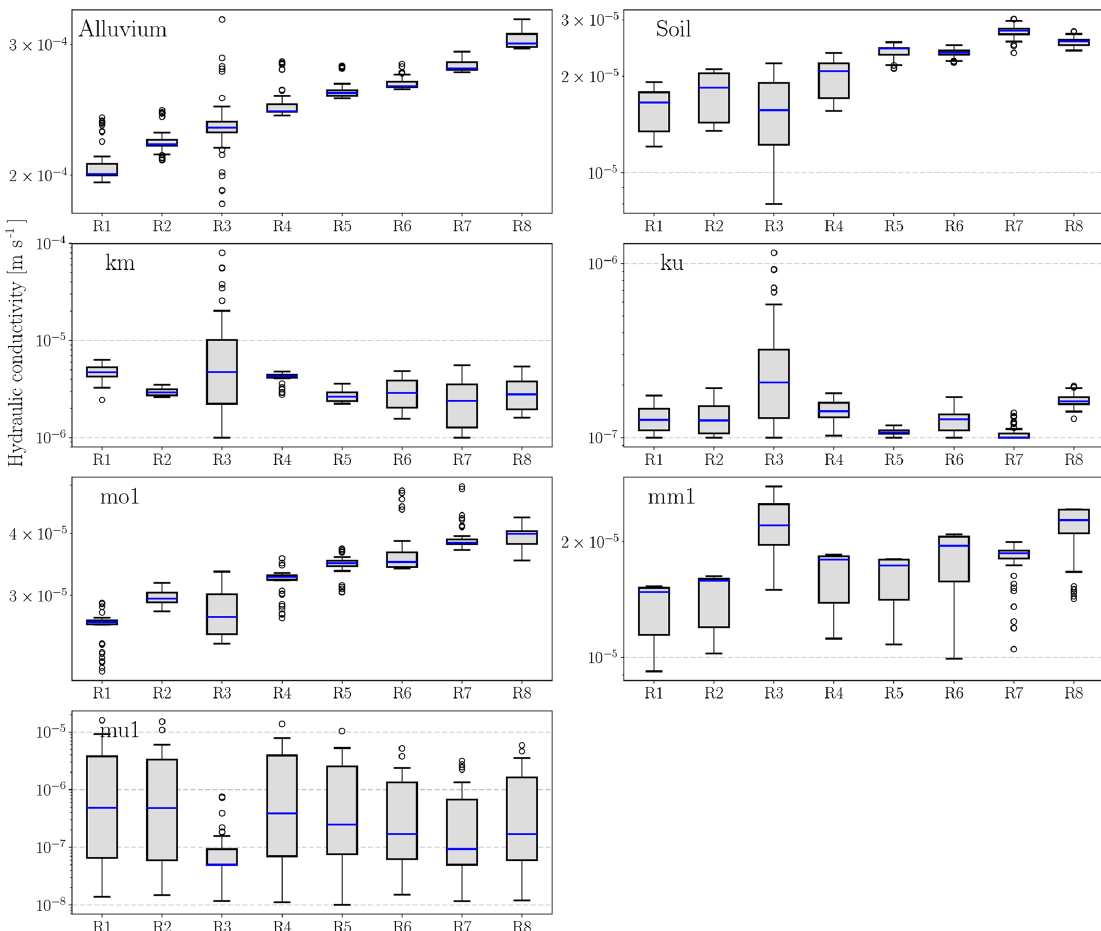
Figure 4. Box-plot of stochastically generated hydraulic conductivity ( K s ) for each geological layer in eight recharge realizations. Note that the parameters mo2, mm2, and mu2 are not shown in this figure because the less permeable subunits of the Muschelkalk (mo2, mm2, and mu2) are tied with the respective more permeable subunits (mo1, mm1, and mu1) with a factor of